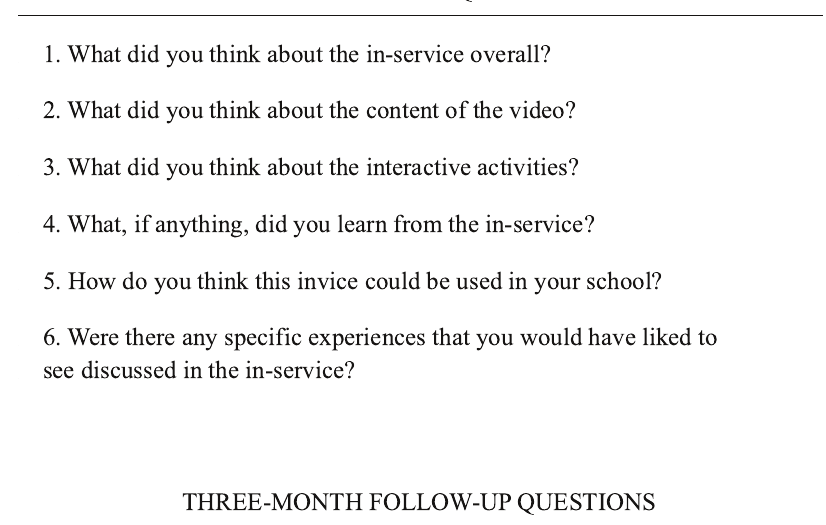
Focus Group Questions at Post- In-service and Three-Month